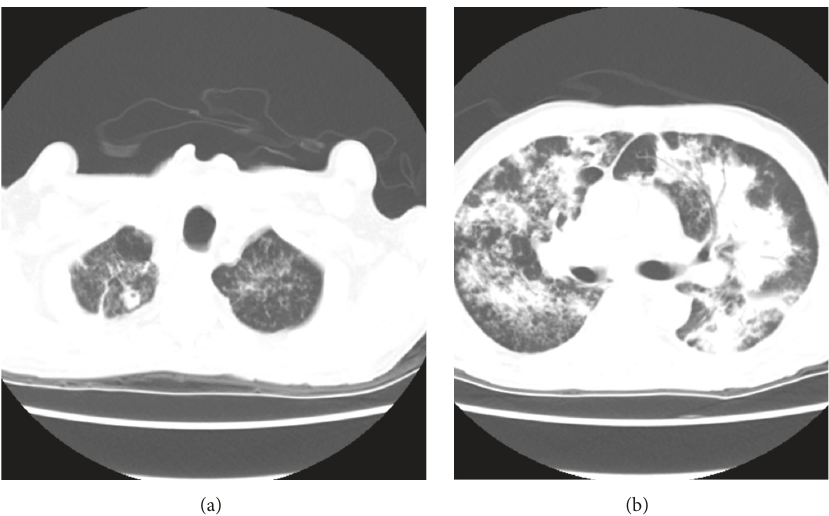
Figure 4: CT chest with IV contrast taken on day 13. (a) shows right upper lobe cavitary lesion. (b) shows multilobar consolidation.